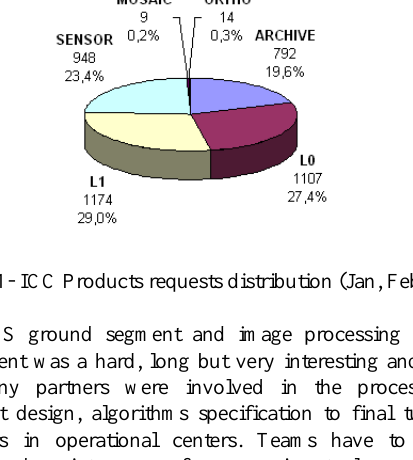
processing tools, as well